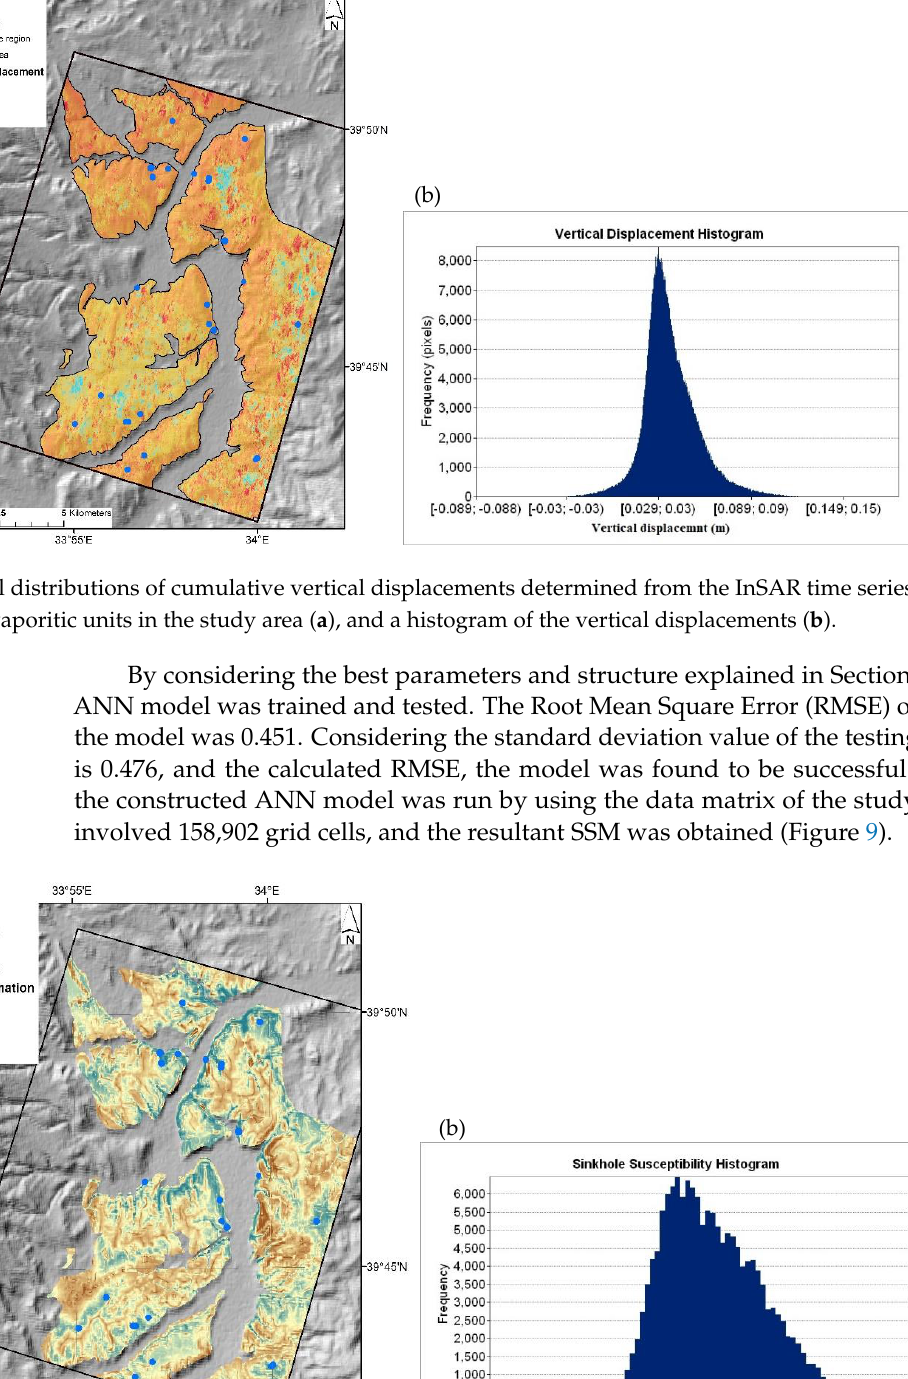
Figure 7. The DEM generated from the Sentinel-1 datasets for 2018 ( a ); the spatial distributions of convergence index ( b ), closed depressions ( c ) topographic wetness index ( d ), slope length factor ( e ), and vertical distance to channel network ( f ) in the study area.